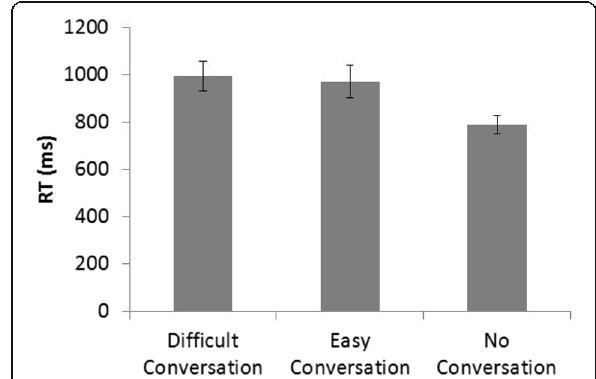
Fig. 2 Reaction times (RTs) for each condition in experiment 1. Error bars represent the standard